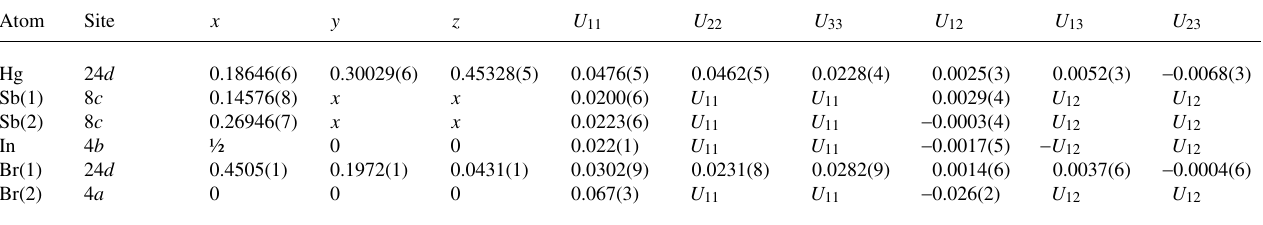
Table 4. Atomic coordinates and displacement parameters (in Å 2 )